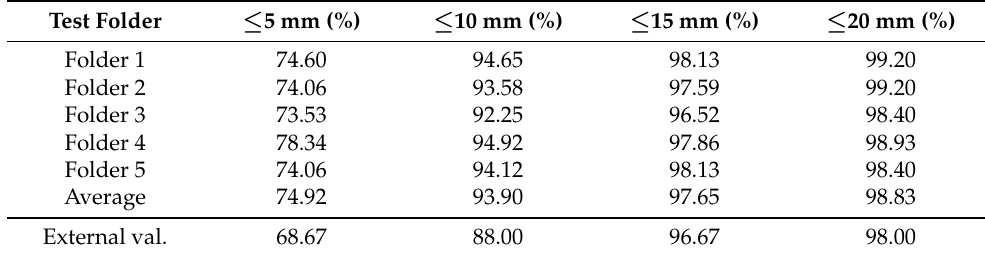
Table 8. The object error distribution in Carina.